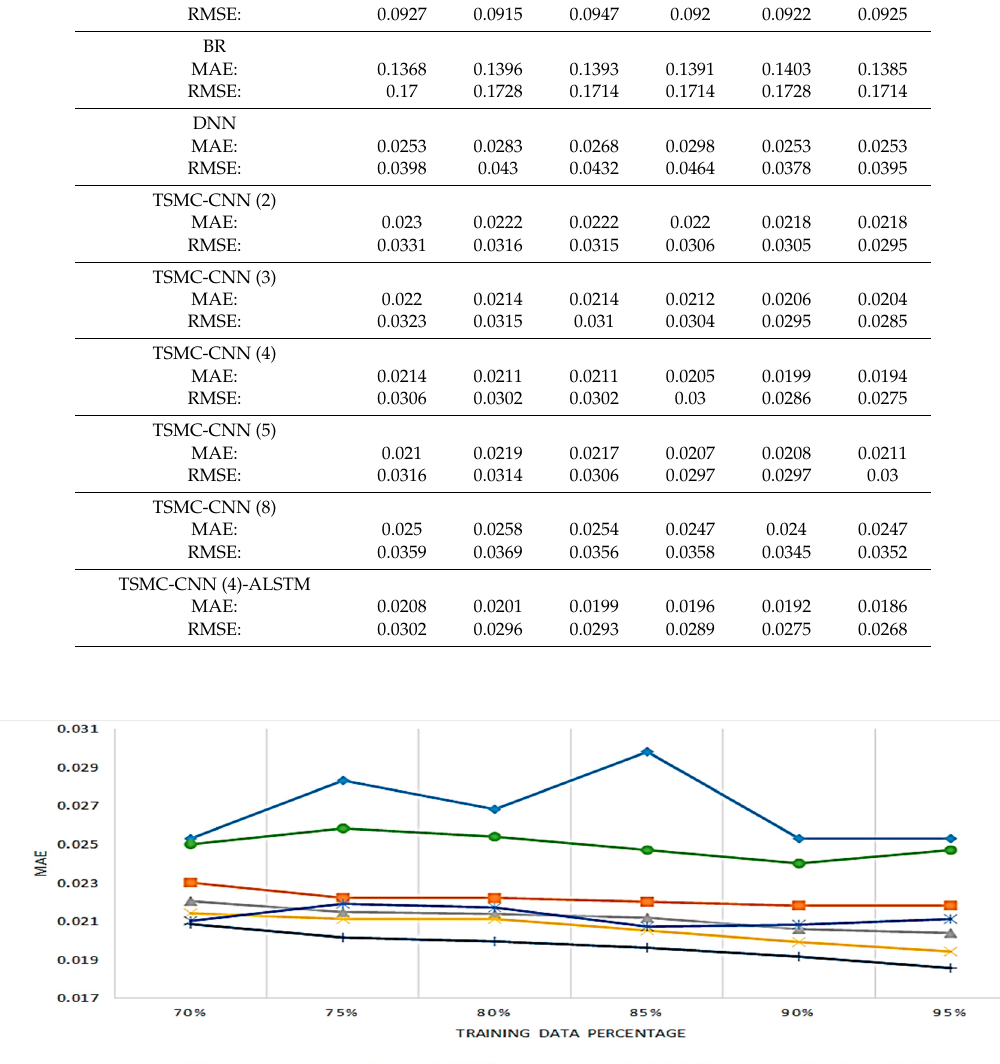
Figure 14. Comparisons of DNN, TSMC-CNN and TSMC-CNN-ALSTM with different numbers of channels in terms of the RMSE. 5. Conclusions This paper proposes two deep learning methods, called TSMC-CNN and TSMC-CNN-ALSTM, for RUL prediction of bearings. The methods have the advantageous end-to-end property that they take raw data as input and generate the predicted RUL directly. The time series data of bearings are first divided into multiple channels to be fed into the CNN for predicting the RUL of bearings directly. The CNN performs well in extracting a relationship between data points; dividing a time series into multiple channels helps the CNN extract relationship among far-apart data points. The TSMC-CNN method thus has good prediction performance. The LSTM network is excellent for processing temporal data, and the attention mechanism allows the LSTM network to focus on different features at different time steps. Therefore, the TSMC-CNN-ALSTM method, which integrates the TSMC-CNN with the ALSTM network, is even better than the TSMC-CNN method. The PRONOSTIA bearing operation datasets [40] are used for performance evaluation. The proposed methods are also compared with the DNN, GBDT, SVM, BPNN, GR, and BR methods, as described in [30]. The comparison results show that the proposed methods are better than others in terms of the MAE and the RMSE of the RUL prediction. The investigations of the bearing RUL prediction problem in this paper show again that the proposed deep learning methods outperform other kinds of data-driven methods. In the future, we plan to do a comprehensive performance comparison study of the proposed methods with more deep learning RUL prediction methods. Furthermore, we also plan to apply different deep learning methods, their integration, and/or their variants to solve the problem for achieving better prediction performance.